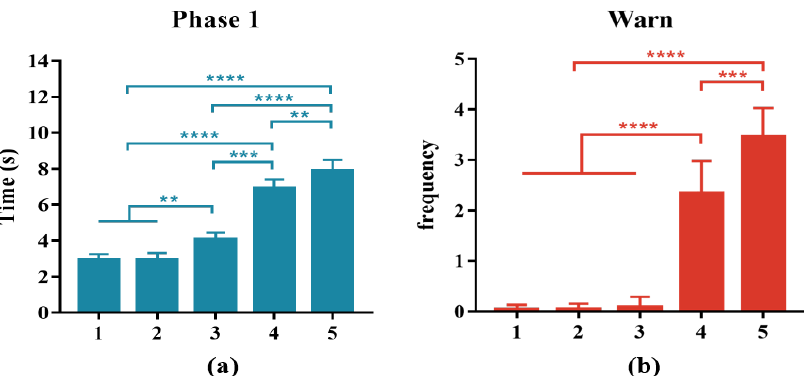
Figure 7. ( a ) Mean ± SD of task completion times for human operators in phase 1 in areas Ⅰ ~ Ⅴ . ( b ) Mean ± SD of warning frequency for human operators in areas Ⅰ ~ Ⅴ . ** denotes p < 0.01, *** denotes ( b ) Mean ± SD of warning frequency for human operators in areas I~V. ** denotes p < 0.01, *** denotes p < 0.001, and **** denotes p < 0.0001. p < 0.001, and **** denotes p <